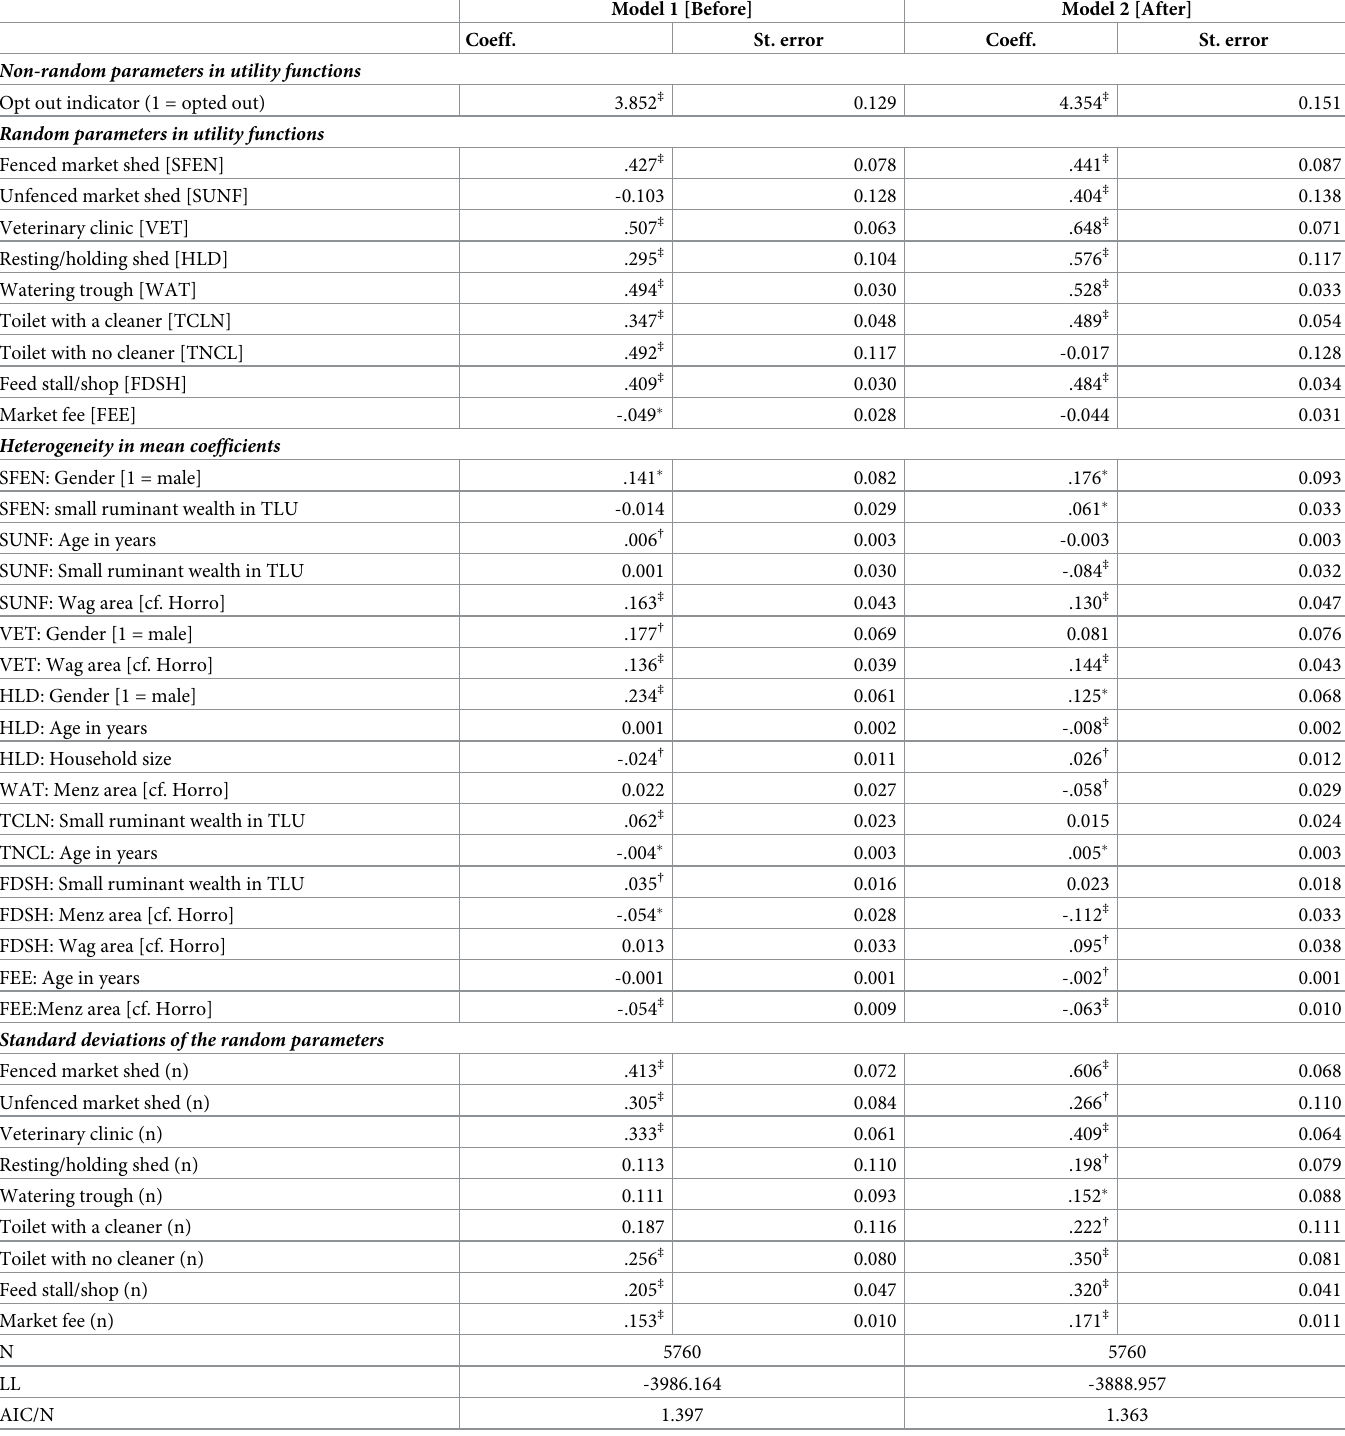
Table 5. Preference heterogeneity in mean before and after attention reminder. Model 1 [Before] Model 2 [After] Coeff. St. error Coeff. St.